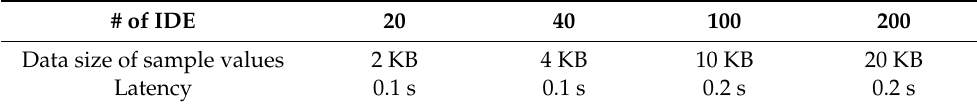
Table 3. Latency sample value through a Large-scale distributed system.